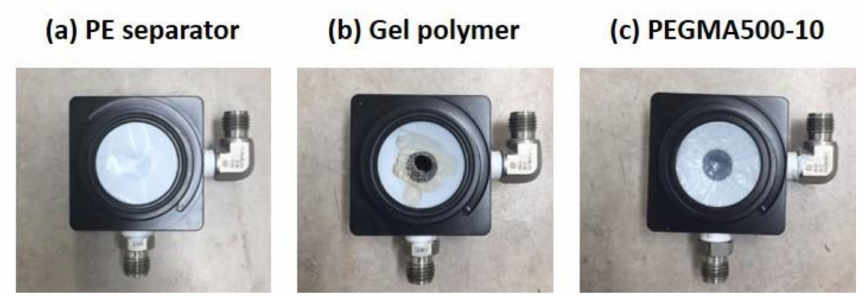
Figure 2. Structure of the pressure-loaded blister test